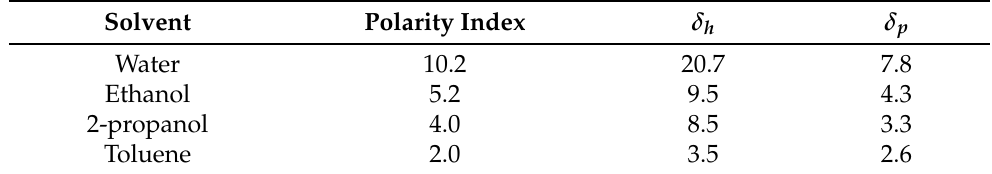
Table 1. Hansen solubility parameter for polar solvents.